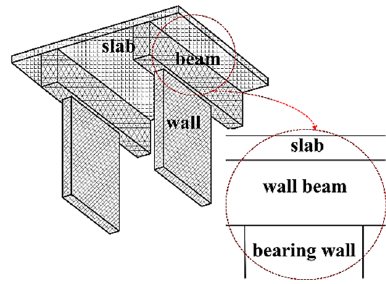
Figure 2. Wall-beam-slab assemblies.